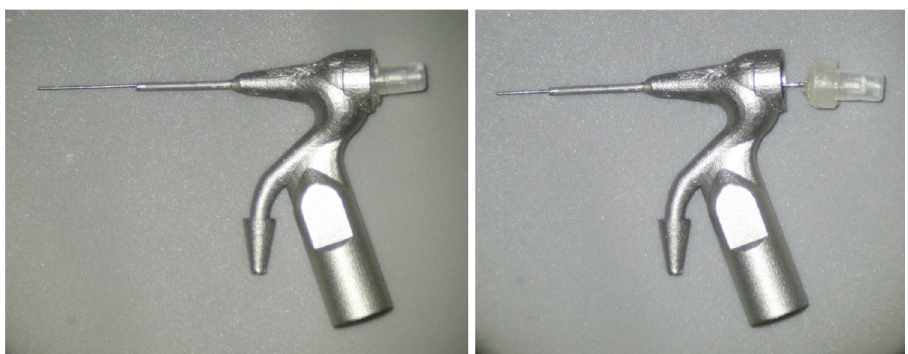
Figure 4. Images showing the assembly of the device (introduction of the micro-cannula into the body and radiographically and by direct exploration. The same operator performed all experimental procedures. Each specimen was sectioned to a working length of 16 mm. The working length was established under a microscope